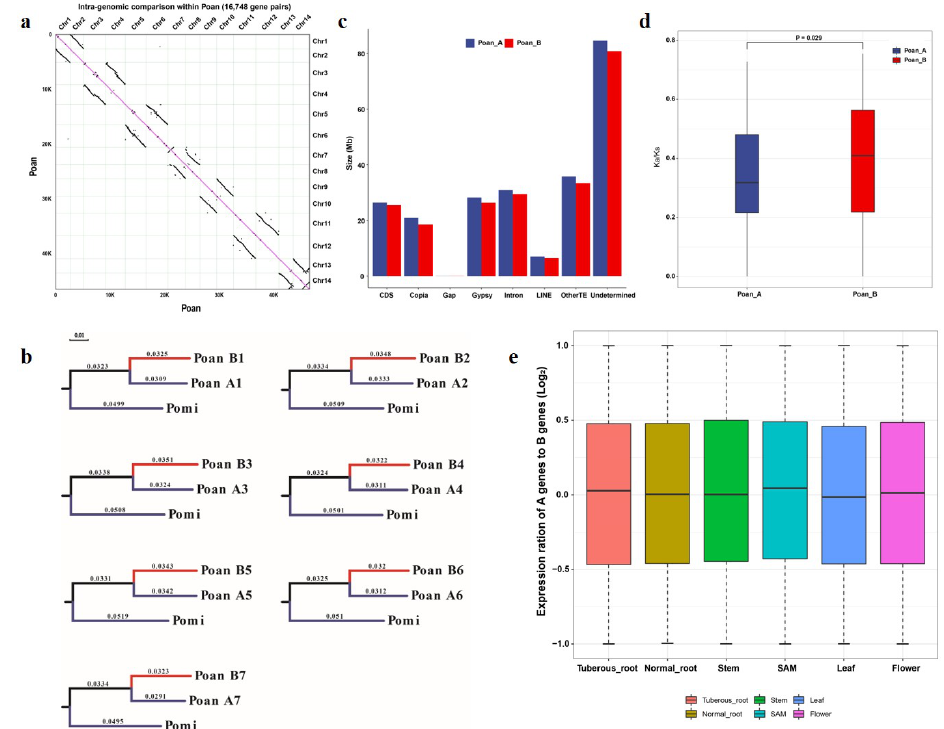
Figure 4. Sub-genome structure and expression dominance analysis. ( a ) Intra-genome gene synteny within Poan 14 chromosomes. ( b ) The phylogenetic tree of single copy genes between Pomi and Poan sub-genomes. ( c ) Sub-genome constitution of Poan. ( d ) Ka/Ks values of two sub-genomes. ( e ) Expression values for co-expression of homoeologous gene